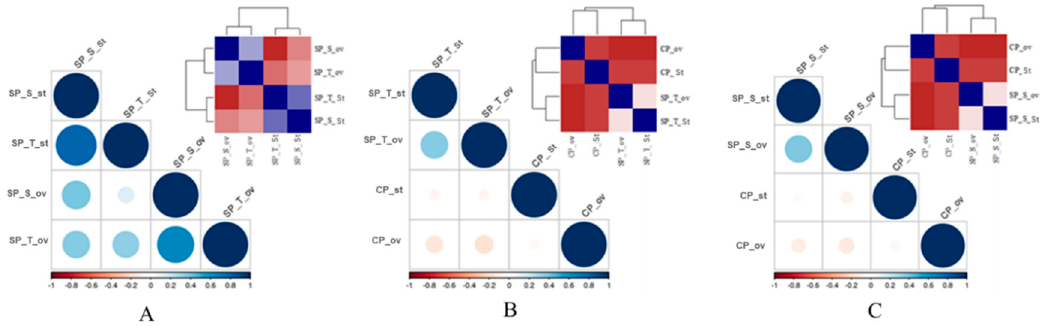
Figure 6. Tissue specific (style vs. ovary) and event specific (SP vs. CP) qRT-PCR expression correlation plot (correlation matrix and correlogram) of 42 key genes involved self-incompatibility and fertilization. ( A ) Tissue-specific correlation between self-pollinated tissues. ( B ) Event specific correlation between SP_S style and ovaries and ( C ) SP_T style and ovaries with respect to CP style and ovaries. The relative expression pattern is depicted in red-blue scale. Color intensity and size of the circle are proportional to the correlation coefficients. The legend color in the bottom represents the scale of correlation coefficients.